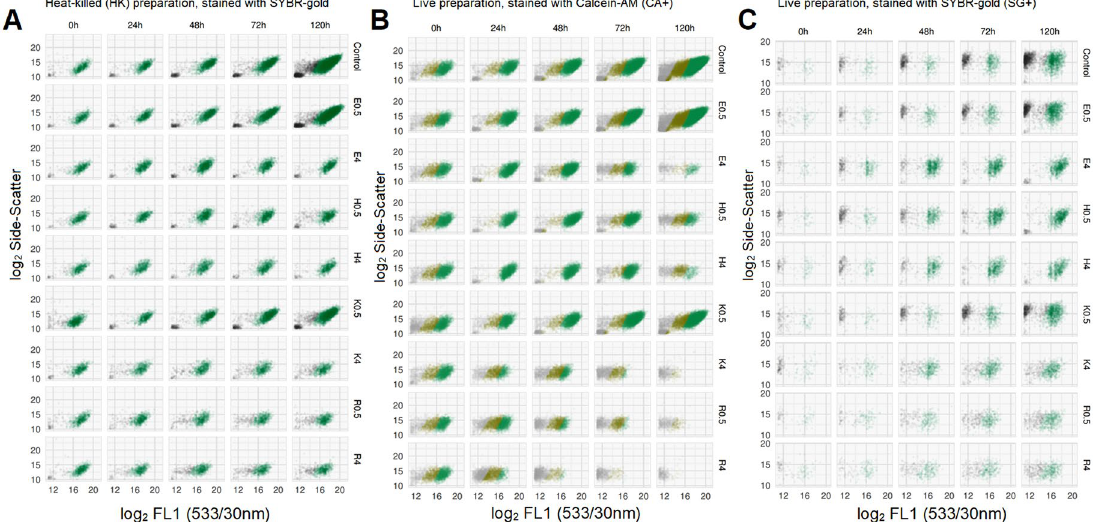
Figure 8. Raw FMC plots of HK, CA + , and SG + events for selected antimicrobial conditions and timepoints. Raw FMC data from one of three independent replicates. SYBR-gold stained heat-killed (HK) samples (A, left), Calcein-AM stained live samples (B, middle), and SYBR-gold stained live samples (C, right), by antimicrobial condition (rows) and time-point (hours) post introduction of antimicrobials (columns). Antimicrobial indicated by letter prefix (E, ethambutol; H, isoniazid; K, kanamycin; R, rifampicin) and concentration in multiples of MIC 99 by suffix letter (e.g., R4 = rifampicin at 4 × MIC). FCM events in each plot are coloured by K-means clustering on all light-scatter and fluorescence dimensions—an unsupervised classification (machine learning) algorithm used to define subpopulations without subjective manual placement of gates.